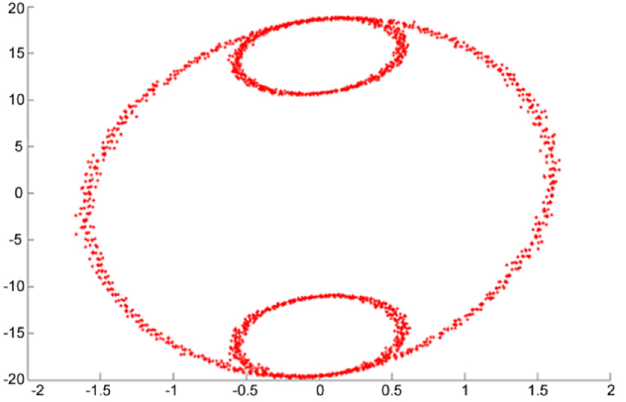
Figure 16. Chaotic trajectory for power system signal with harmonics disturbance and 5%